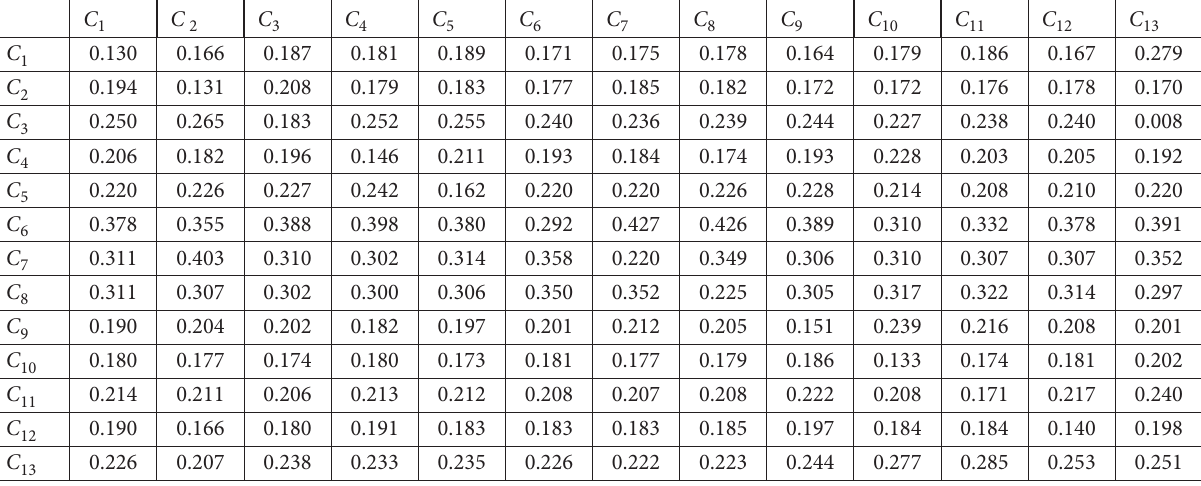
Table 7. Un-weighted super-matrix